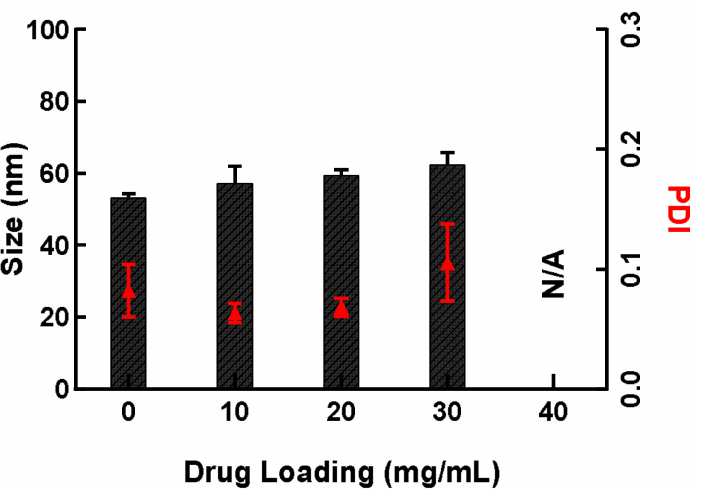
Figure 3. The influence of IP-DHA drug loading on the mean size of NE after the dilution of SNEDDS- IP-DHA in MilliQ water (dilution 1:1000). The columns represent the mean size (nm) and the red triangles the PDI. ( n =